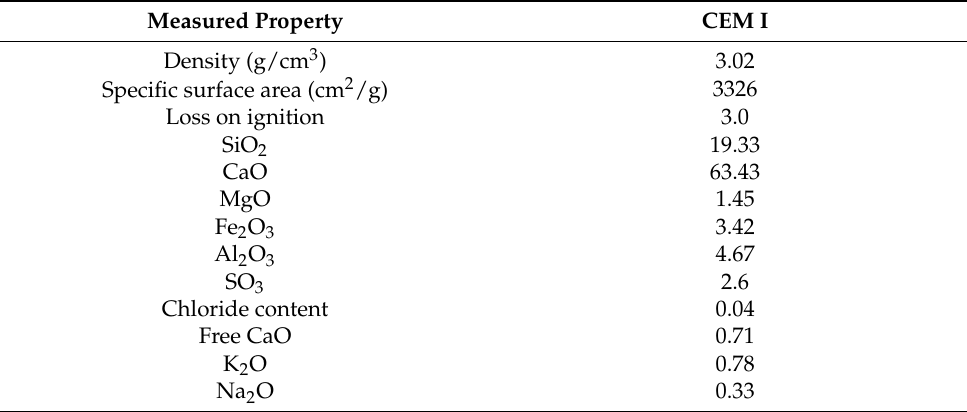
Table 1. Chemical compositions and physical properties of cement.